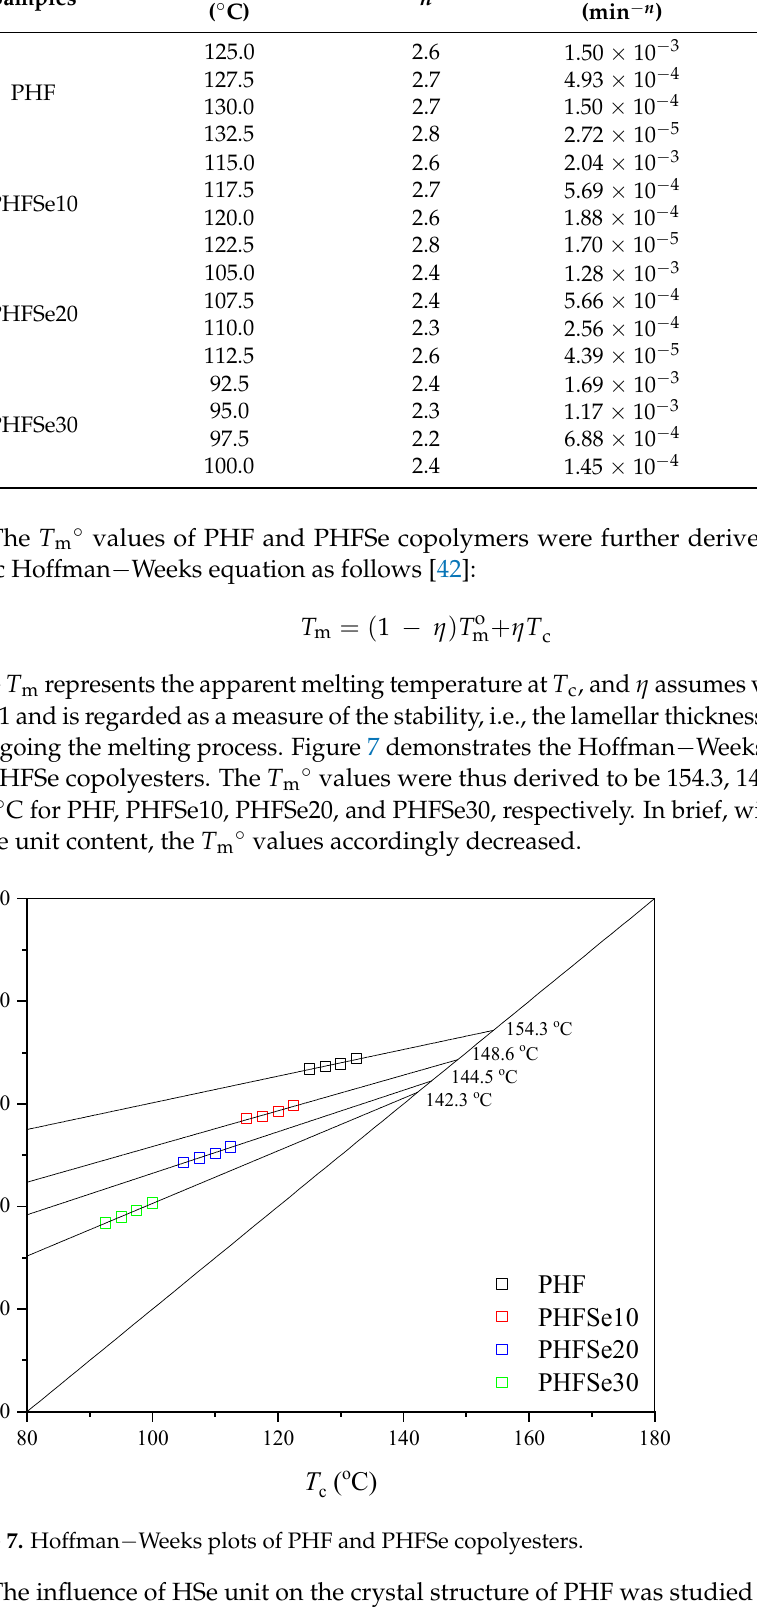
Figure 7. Hoffman − Weeks plots of PHF and PHFSe